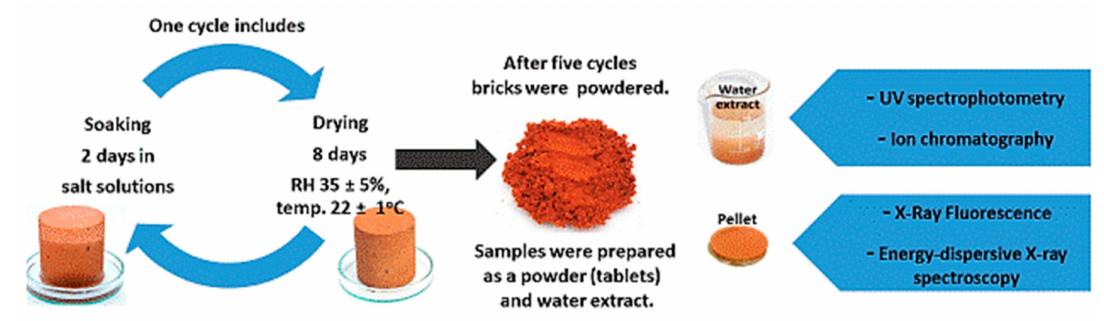
Figure 1. Scheme of soaking in salt solutions of MgCl 2 , KCl, NaCl, MgSO 4 , K 2 SO 4 , Na 2 SO 4 and Mg(NO 3 ) 2 frame of researches. One cycle includes 2 d of soaking and 8 d of